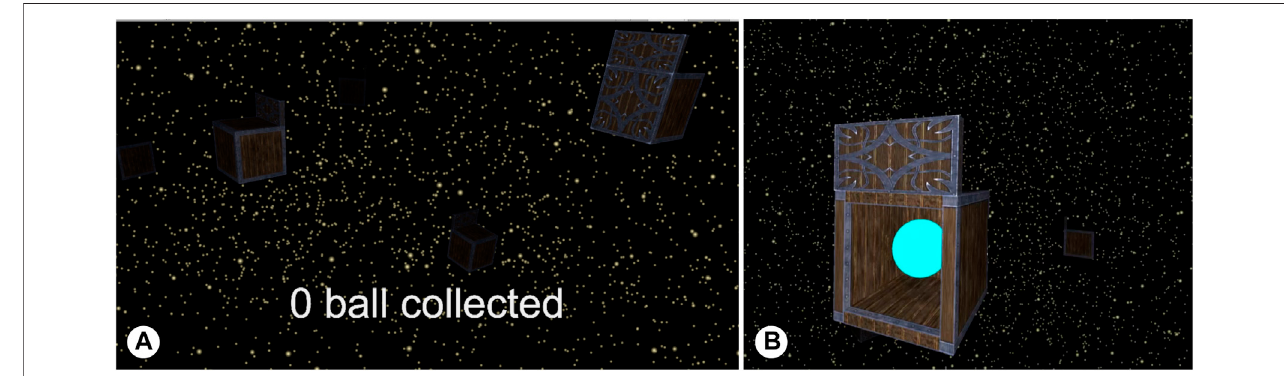
FIGURE 1 | (A) A snapshot of a participant ’ s view of the play area (6 m × 3 m cylinder) with the closed boxes. The light attached to the avatar ’ s head lit half of the playarea,4.24 m.Boxesbecamedimlylitastheirdistanceincreasedfromtheplayerandstoppedbeingvisiblewhentheywerefurtherthan4.24 m. (B) Thetarget,ablue ball, seen after approaching the